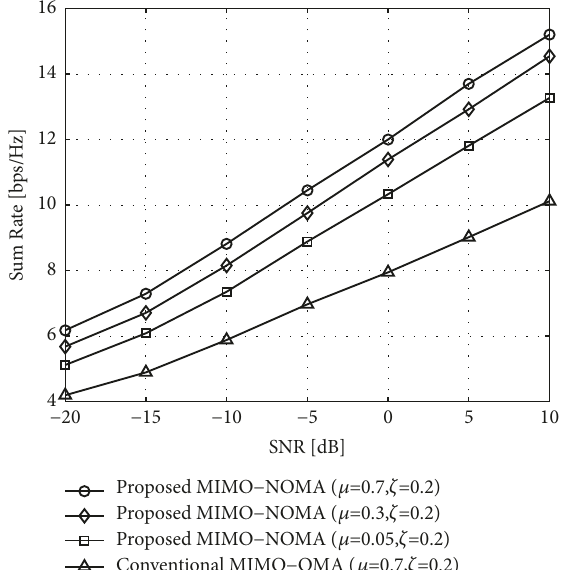
Figure 1: Sum rate performances of the proposed MIMO-NOMA andconventionalhybridZF-BFsystemsagainstSNR( 𝜇 =0.7,0.3,and 0.05; 𝜁 =0.2).